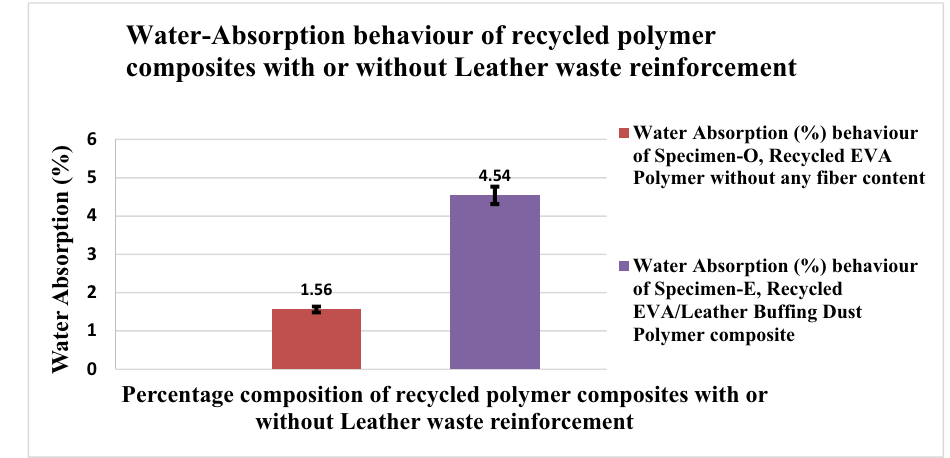
Figure 43: Comparison of water absorption ( % ) of recycled EVA polymer composites with or without leather bu ffi ng